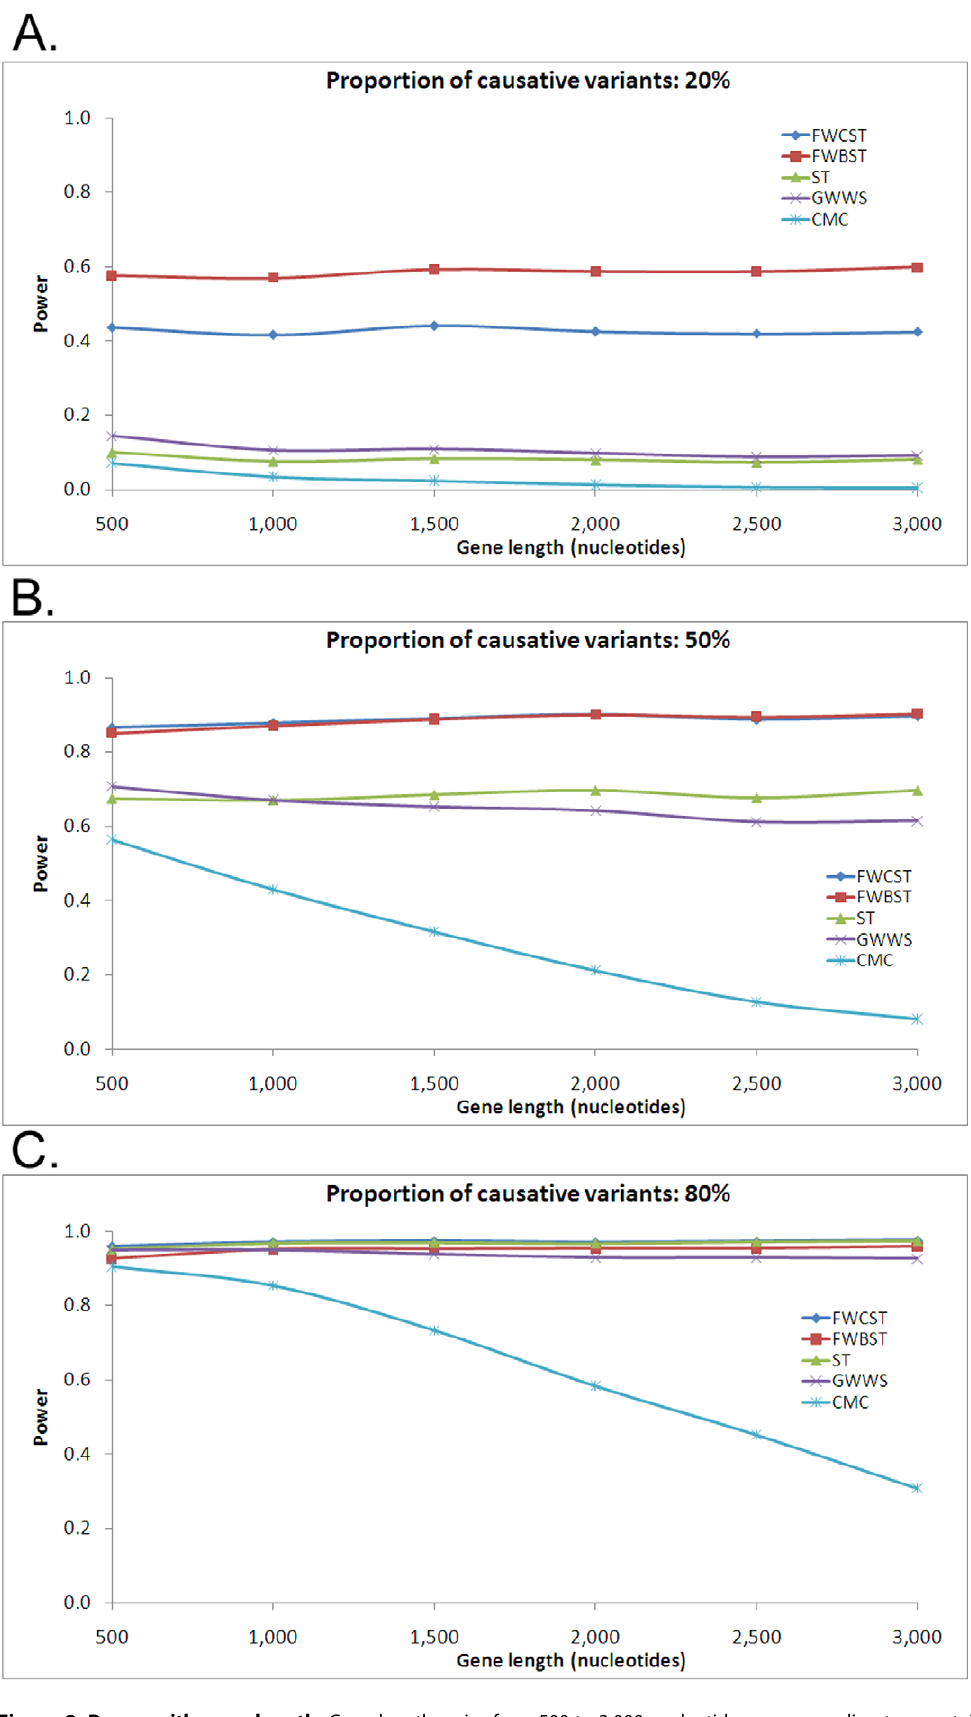
Figure 8. Power with gene length. Gene length varies from 500 to 3,000 nucleotides, corresponding to a protein length of 170 to 1,000 amino acids. See the legend for figure 4 for abbreviations and simulation details. doi:10.1371/journal.pone.0013857.g008 PLoS ONE |